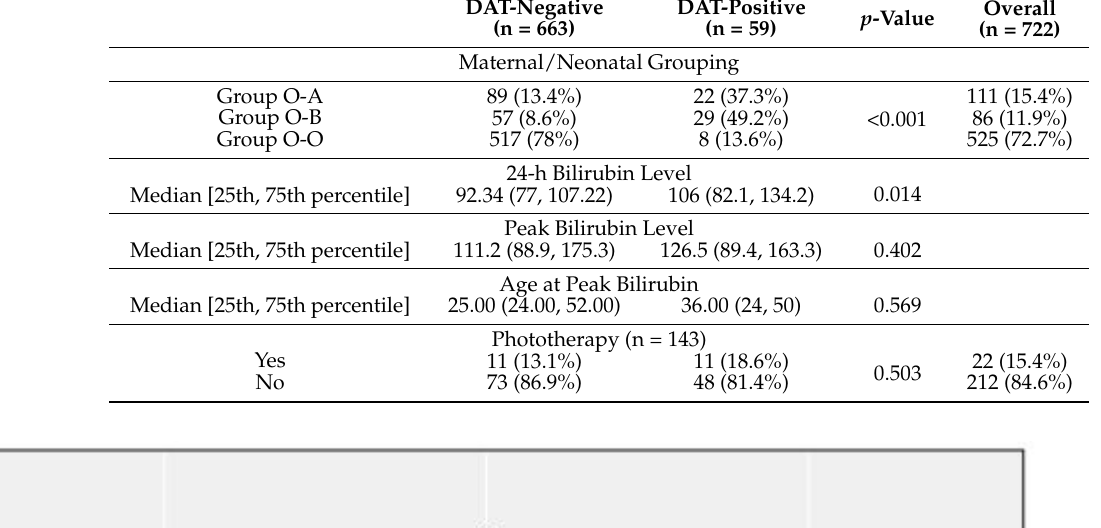
Table 3. DAT results in maternal group O. p -Value calculated by chi-square for categorical data, and Mann–Whitney U test for continuous variables.